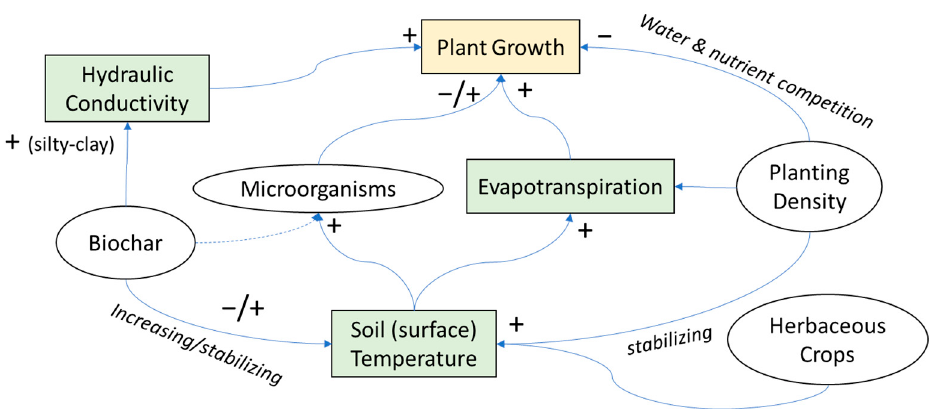
Figure 9. Hypothetical interactions between component factors in a restoration trial experiment. The interactions are complex, and all the factors can contribute to plant growth dynamics.